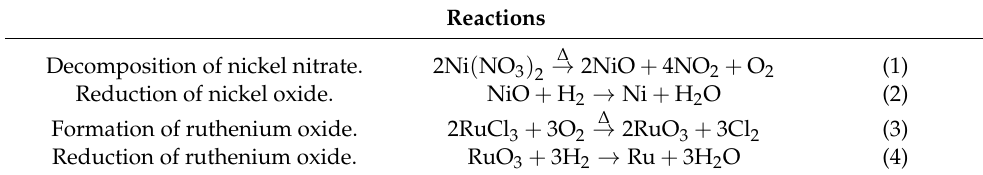
Table 2. Reactions to obtain Ni and Ru.